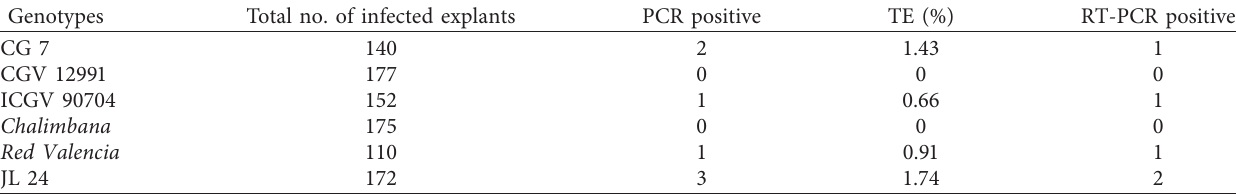
Table 2: Transformation efficiency.